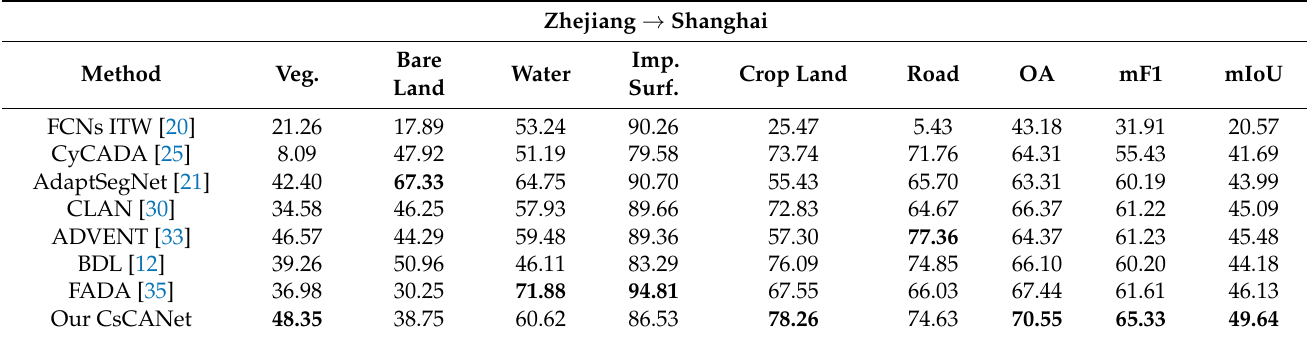
Table 4. Comparison results on the task Zhejiang → Shanghai (%). We study the performance using the Zhejiang dataset as annotated source data and the Shanghai training set as the unlabeled target domain. The best results are highlighted in